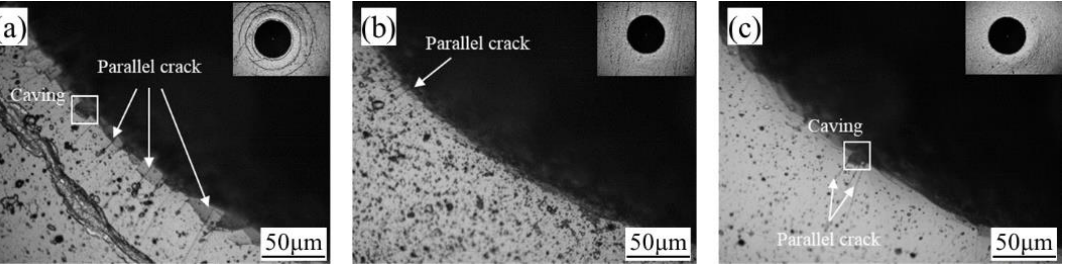
Figure 9. Surface indentation morphology of Si-DLC with different transition layers: ( a ) AlTiSiN/Si-DLC; ( b ) AlCrN/Si-DLC; ( c ) AlTiCrN/Si-DLC.